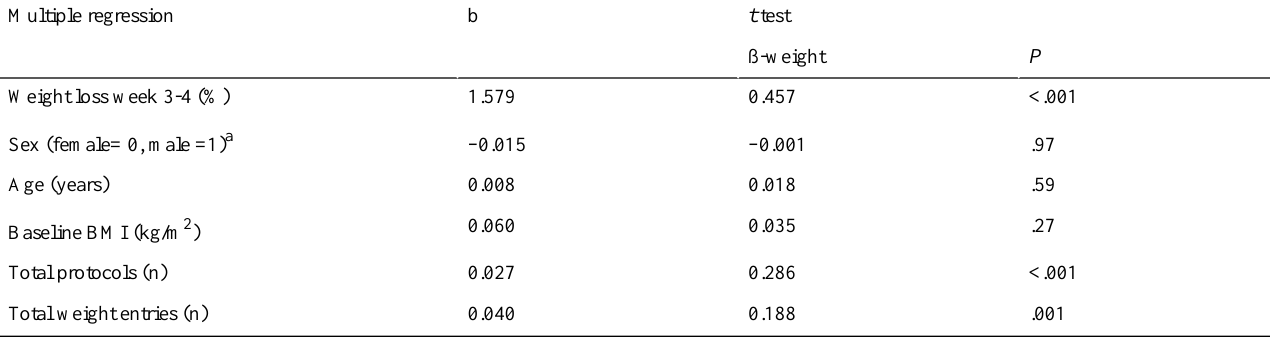
Table 3. Multiple regression analyses including regression coefficients (b) and standardized regression coefficient (ß-weight) for predicting percentage weight reduction after 6 months of program